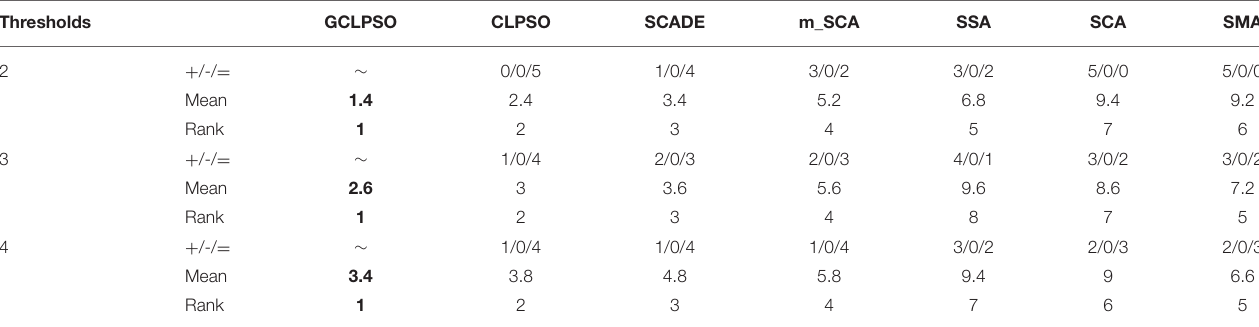
TABLE 6 | Results of the PSNR comparison by the Wilcoxon signed-rank test at each threshold level of maize gray spot disease. Thresholds GCLPSO CLPSO